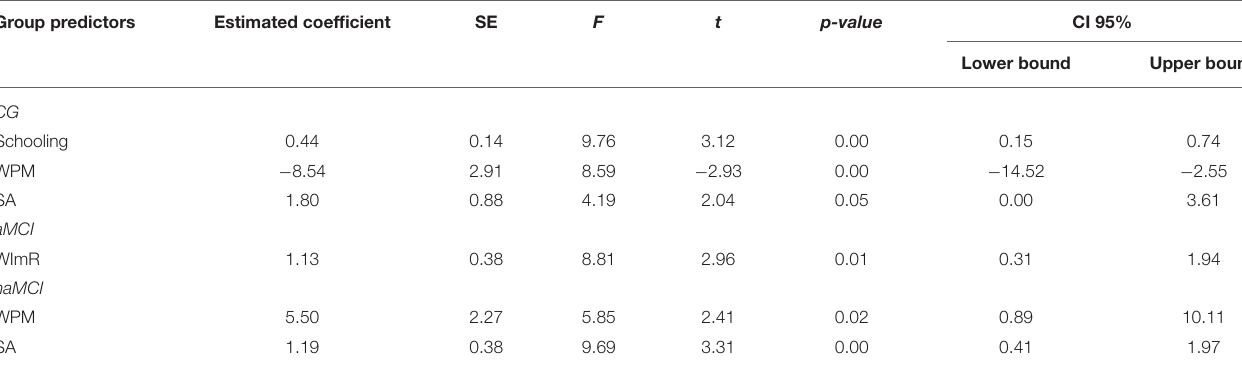
TABLE 4 | Mixed-effect linear regression for predictors of IMT scores by diagnostic group. Group